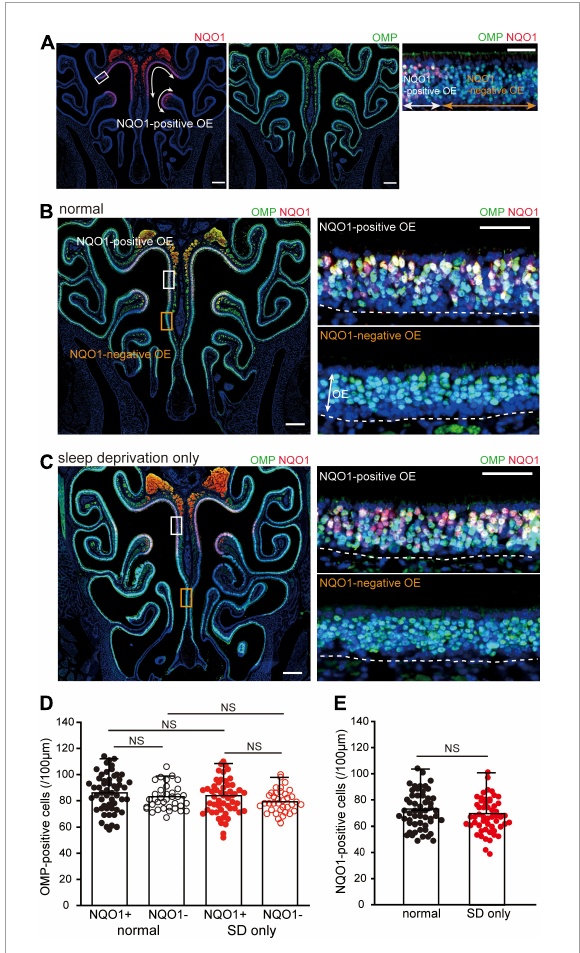
FIGURE2 Sleep deprivation (SD) does not induce histological changes in the OE. (A) Photomicrographs of representative coronal sections from normal mice stained with anti-NADPH quinone oxido-reductase 1 (NQO1) antibody (left, red) and anti-olfactory marker protein (OMP) antibody (middle, green). Mature olfactory sensory neurons (OSNs) were evenly distributed within the OE, but NQO1-positive OSNs were confined to the upper nasal septum and upper concha bullosa, as indicated by the arrow range. Left and middle images, lower magnification; right image, higher magnification image of the area indicated by the square in the left image. Scale, 300 µ m at low magnification; 50 µ m at high magnification. (B,C) Photomicrographs of representative coronal sections from normal (B) and SD mice (C) stained with anti-OMP antibody (green) and anti-NQO1 antibody (red). Images on the right show higher magnification images captured from the areas indicated by the squares on the image on the left (upper, NQO1-positive OE; lower, NQO1-negative OE). The dashed line represents the basement membrane of the OE. Scale, 300 µ m at low magnification; 50 µ m at high magnification. OE, olfactory epithelium. (D) Counts of OMP-positive cells of NQO1-positive (NQO1+) and NQO1-negative (NQO1 –) OEs in normal and SD only mice (SD only). SD did not induce changes in the number of OMP-positive cells between the NQO1-positive and –negative OEs. NS, not significant; Steel–Dwass test. (E) Counts of NQO1-positive cells in normal (black) and SD only mice (red). Significant changes were not observed histologically between normal and SD only mice (NS, not significant, Mann–Whitney